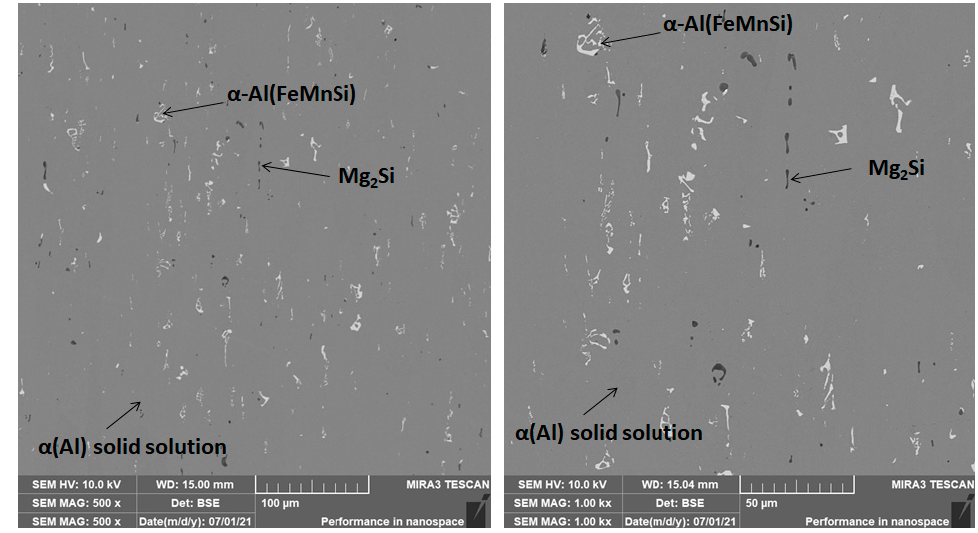
Figure 1. Structure of the delivered material EN AW 6061 (condition T651).